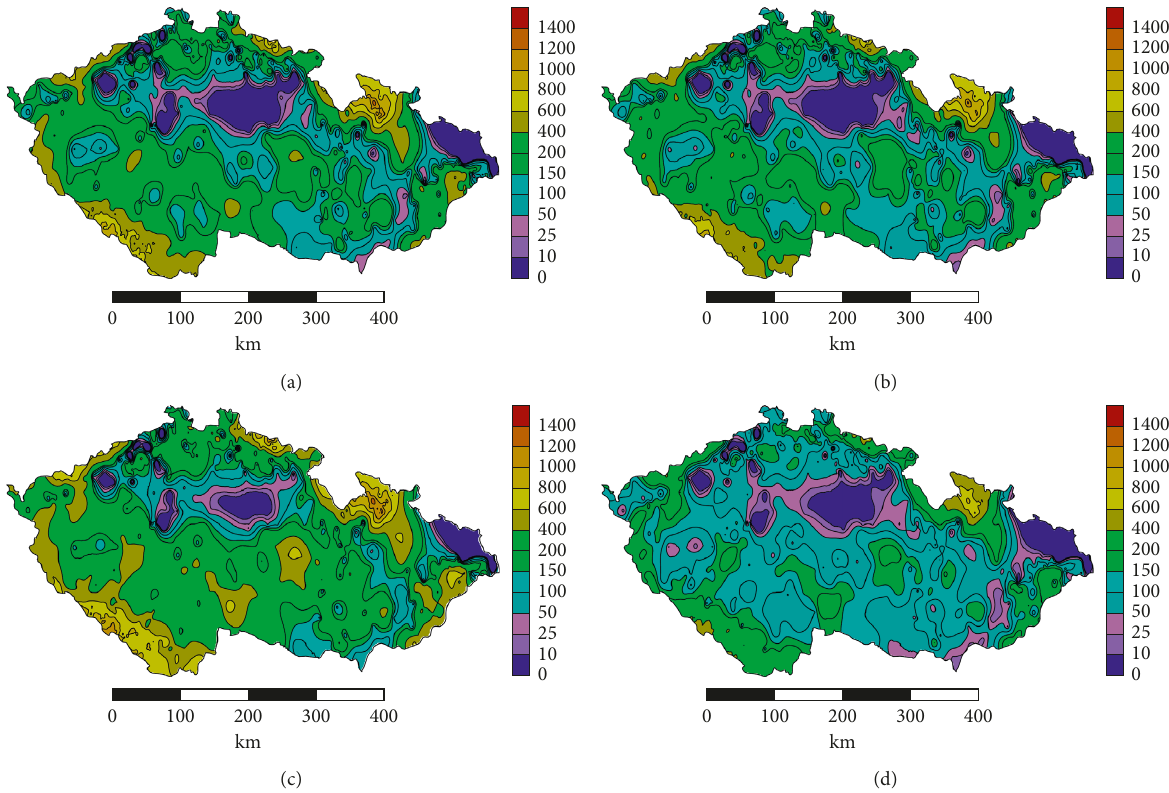
Figure 6: TOF outputs for (a) AAC, (b) ceramic brick, (c) hollow clay brick, and (d) sandstone masonry.